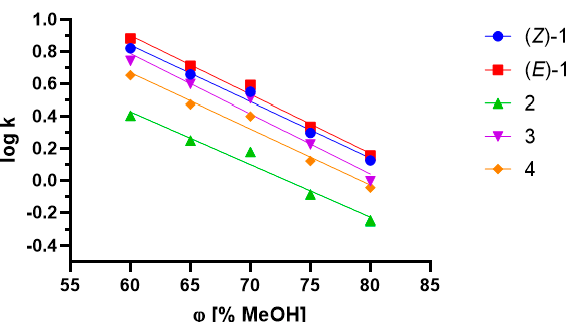
Figure 8. Log k and methanol volume fraction dependence for 3- n -butylidenephthalide ( 1 ); 3-butyl- 3-hydroxyphthalide ( 2 ); 3-butyl-3-methoxyphthalide ( 3 ); and 3- n -butylphthalide ( 4 ).